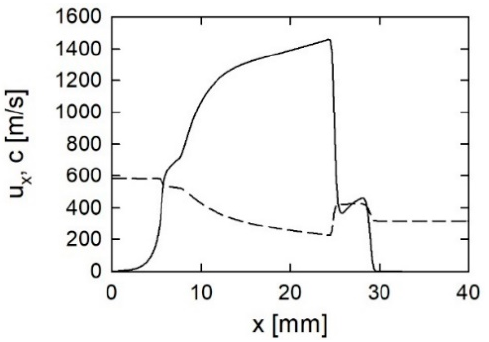
Figure 12. Distribution of the flow velocity (solid line) and the sound velocity (dashed line) along the axis at 20 μ s.